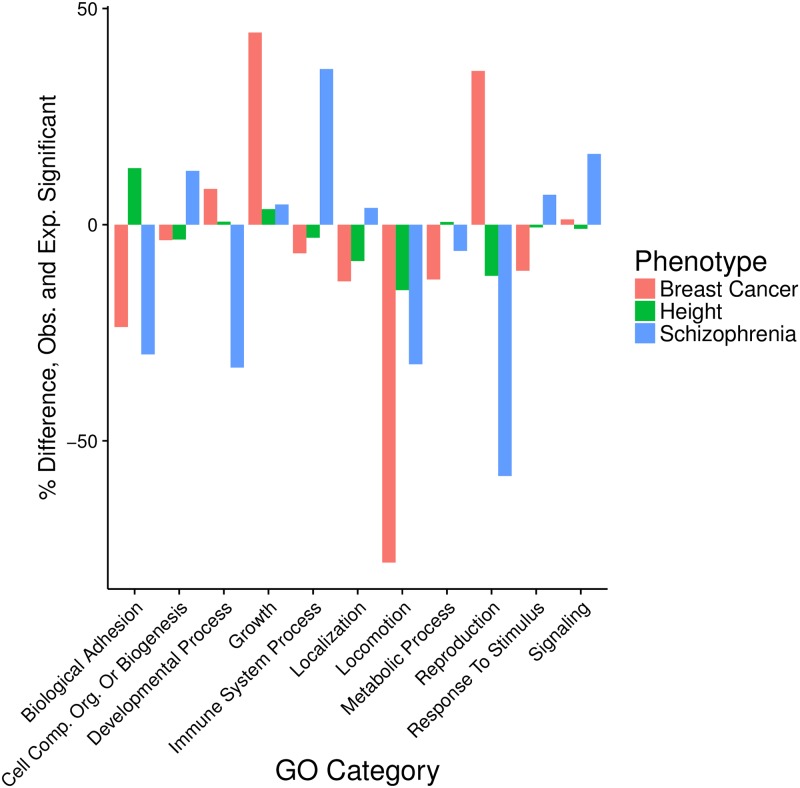
Difference between observed and expected number of significant pathways arising from Gene Ontology Biological Process categories.For a given phenotype, expected number is equal to the percentage of all tested pathways belonging to a category multiplied by the total number of significant pathways. The difference between observed and expected counts is expressed as a percentage of the expected number. A value greater than 0 indicates there are more significant pathways in a category than expected. A value less than 0 indicates there are less significant pathways than expected. A number of familiar themes are present, including the high number of significant height pathways related to growth and the high number of significant schizophrenia pathways related to the immune system.